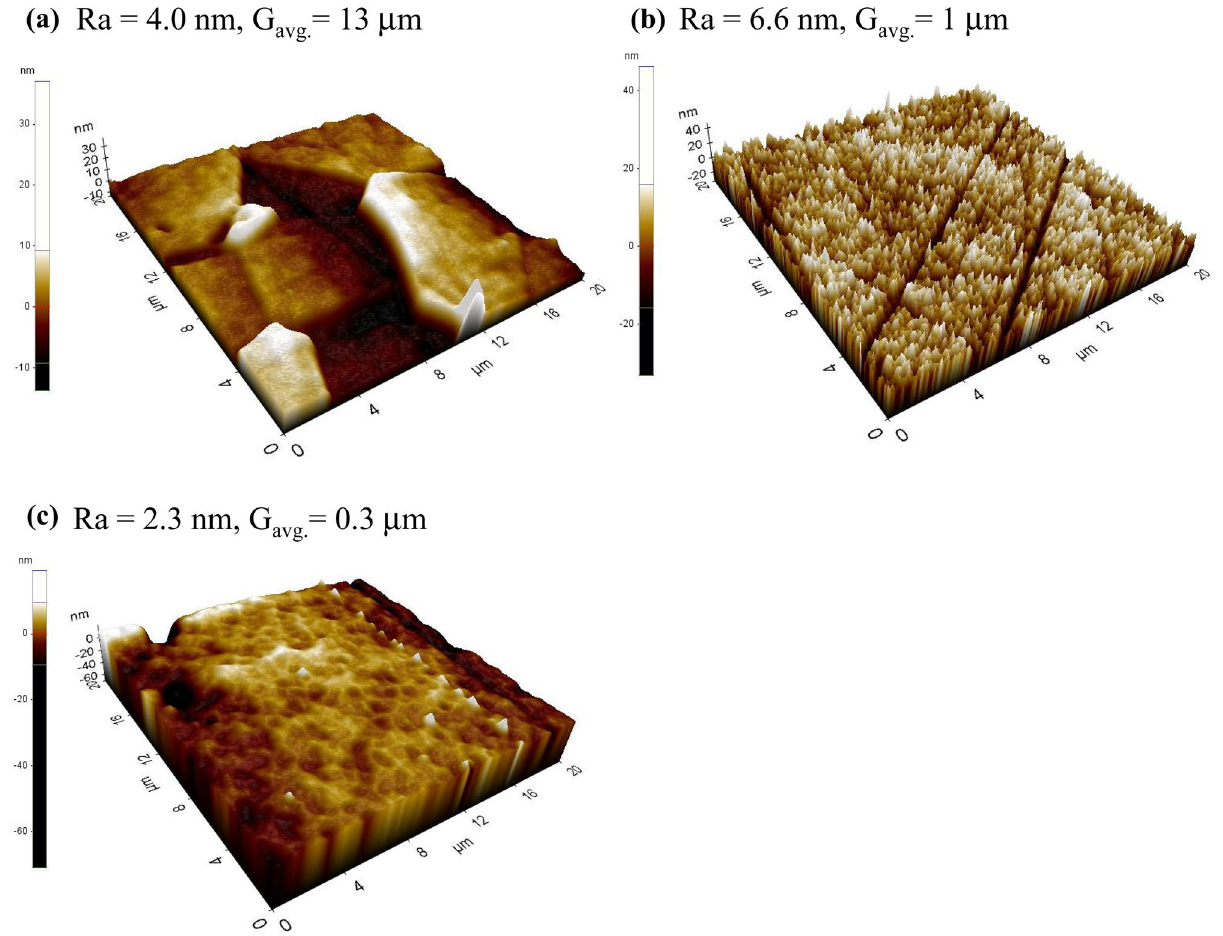
Figure 3. AFM images of plasma etched surface of ( a ) Y 2 O 3 , ( b ) MgAl 2 O 4 and ( c )